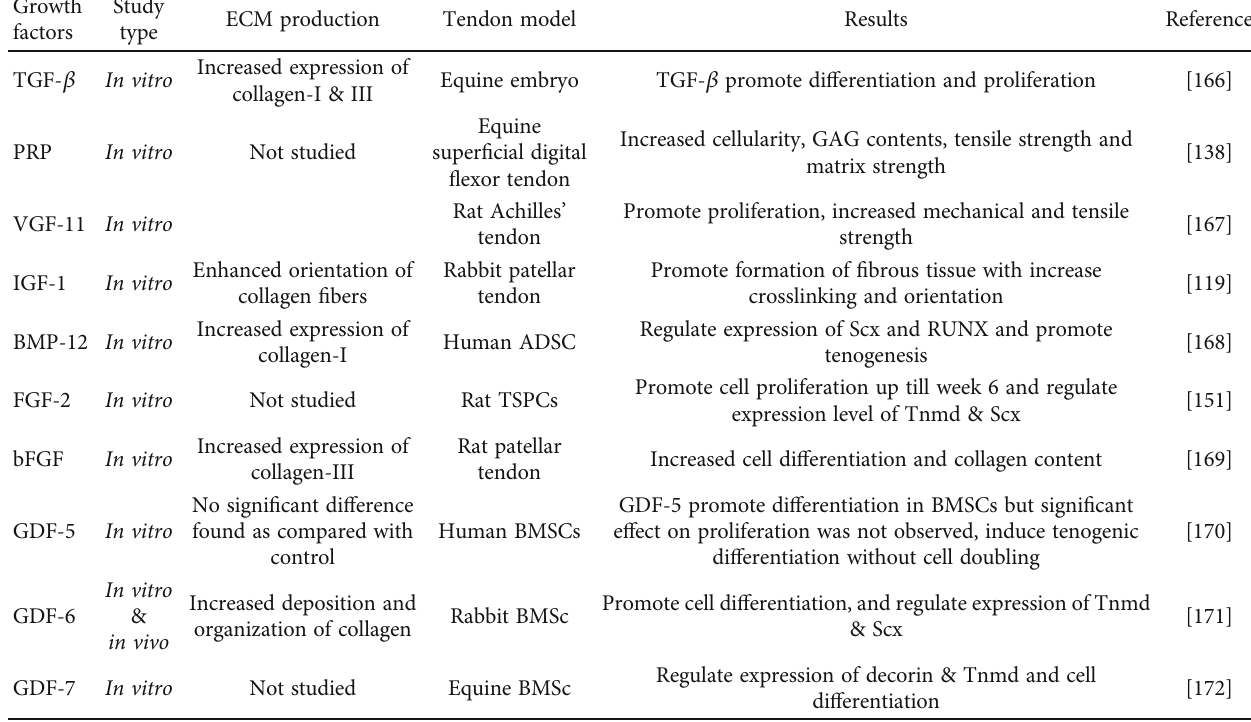
Table 2: Tendogenic growth